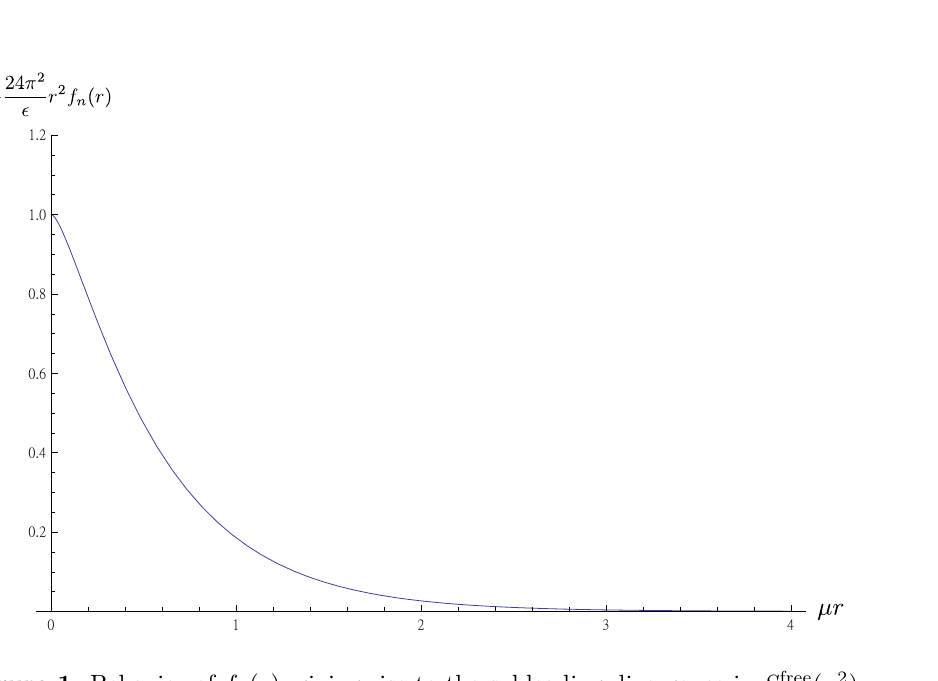
Figure 1 . Behavior of f n ( r ) , giving rise to the subleading divergence in S free